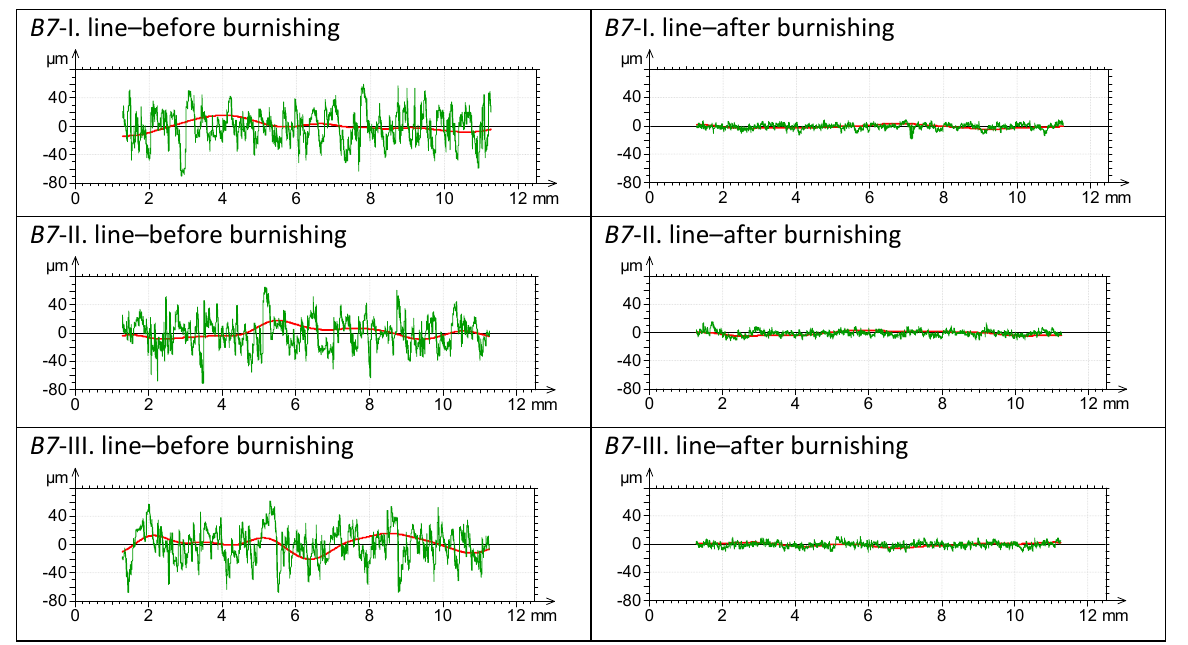
Figure 10. The change in roughness profiles before and after burnishing on specimen B7 on cylinder generatrices, 120° apart.